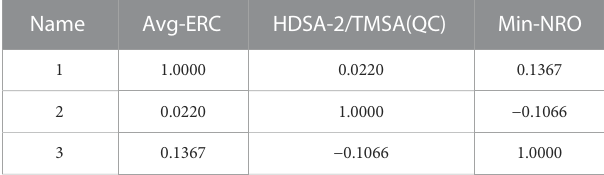
TABLE 3 Correlation coef fi cient between three